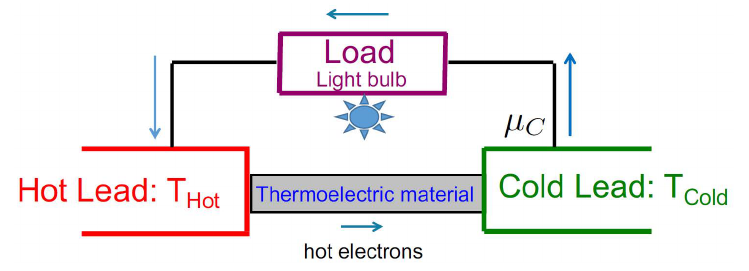
Figure 1. Cartoon of a thermoelectric